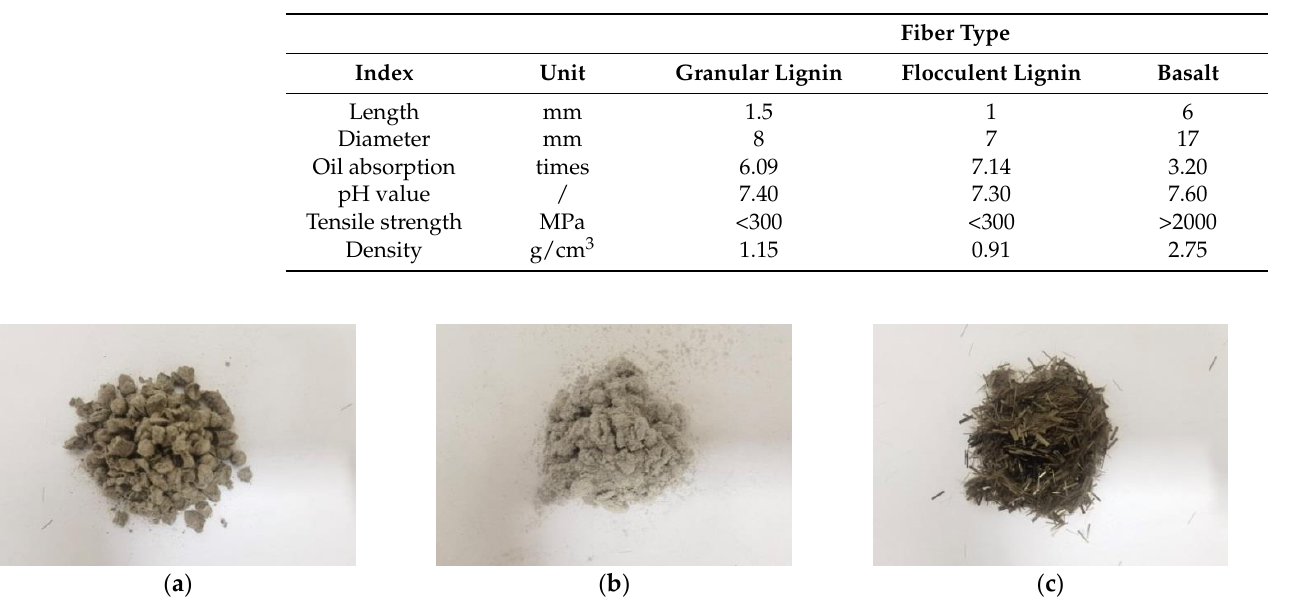
Table 2. Performance of fibers (offered by manufacturers).